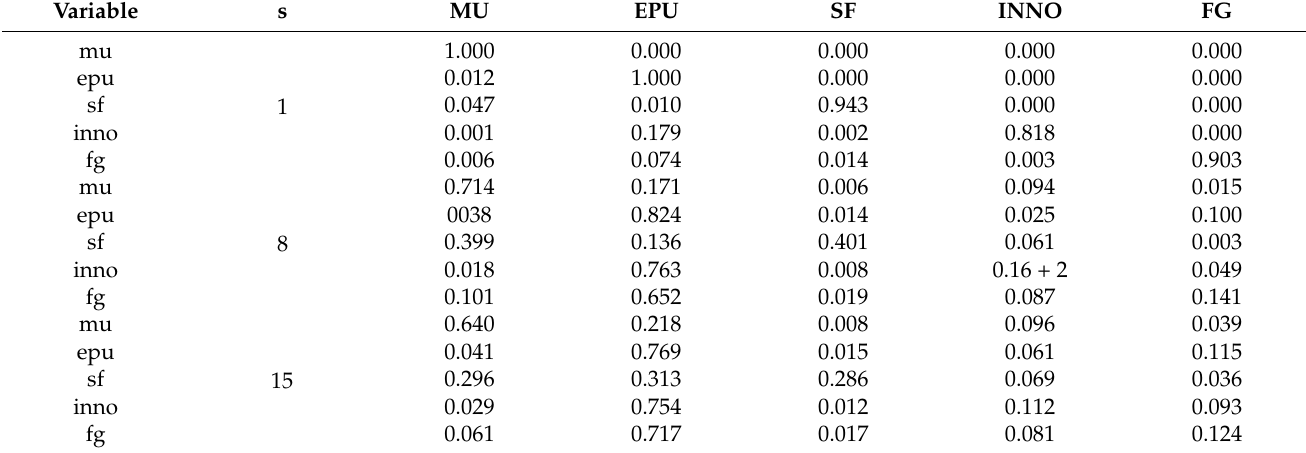
Table 7. Variance decompositions.